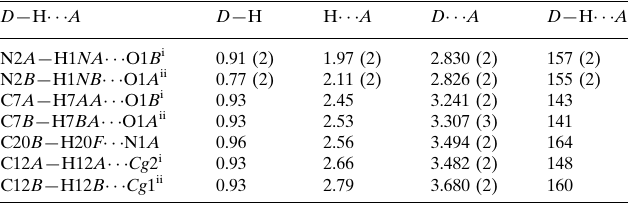
Hydrogen-bond geometry (A˚ , (cid:1)